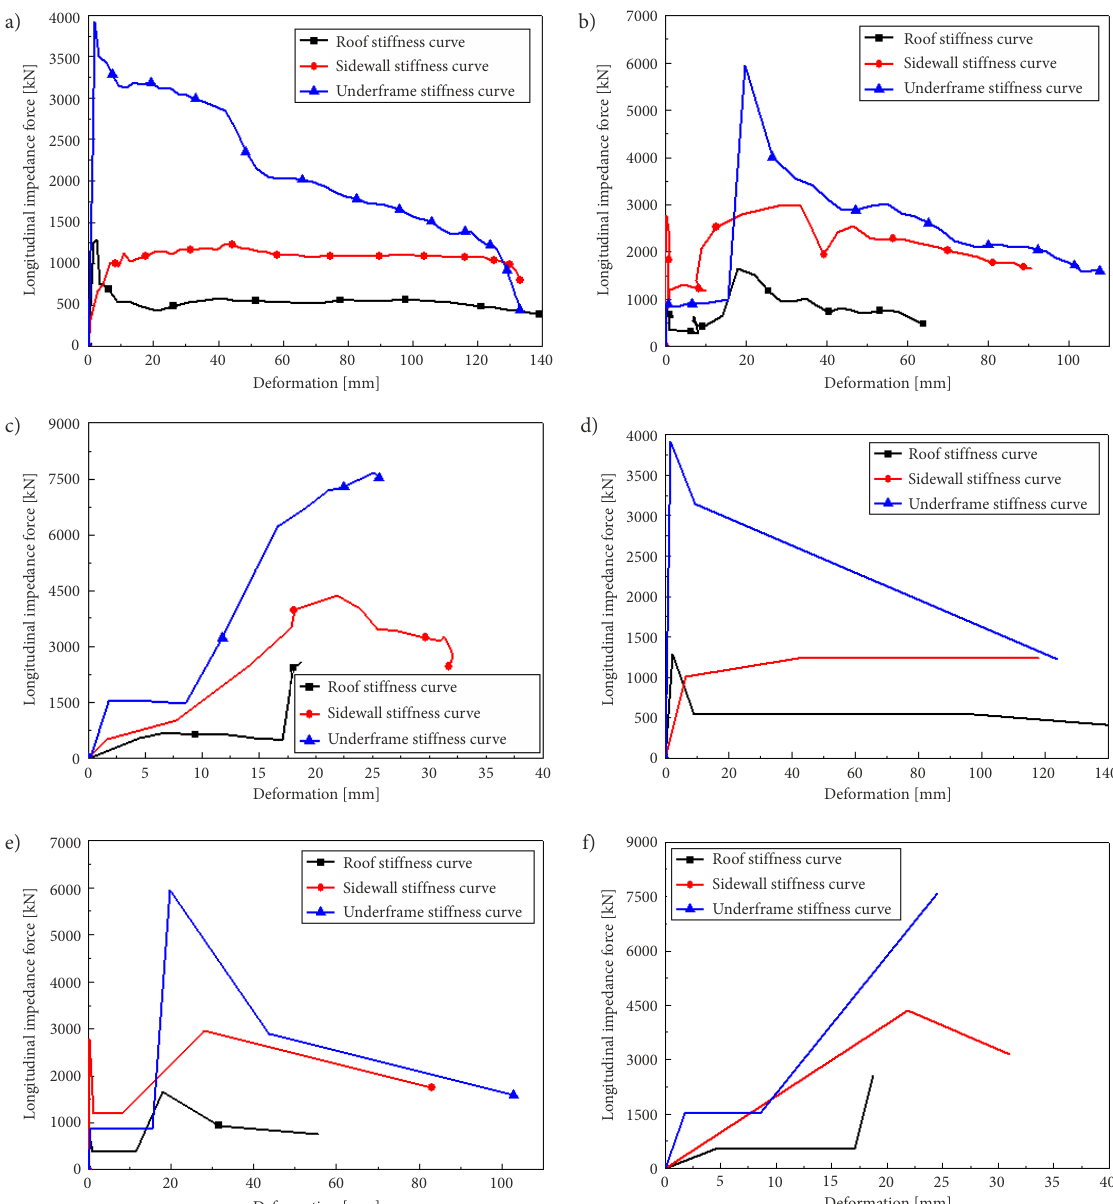
Figure 21. Crushing deformation stiffness curve for three types of vehicles: a – deformation stiffness curve of structural module for type A vehicle; b – deformation stiffness curve of structural module for type B vehicle; c – deformation stiffness curve of structural module for type C vehicle; d – simplified deformation stiffness curve of structural module for type A vehicle; e – simplified deformation stiffness curve of structural module for type B vehicle; f – simplified deformation stiffness curve of structural module for type C vehicle